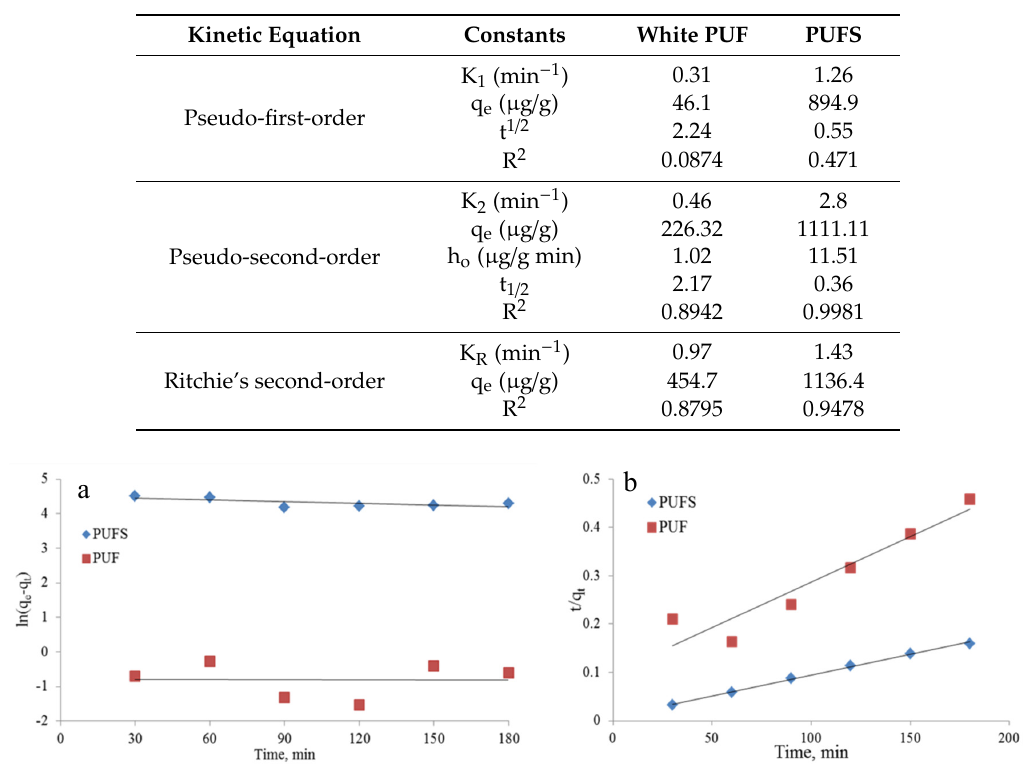
Table 6. Kinetic Constants for Chlorpyrifos Adsorption on White-PUF and PUFS.